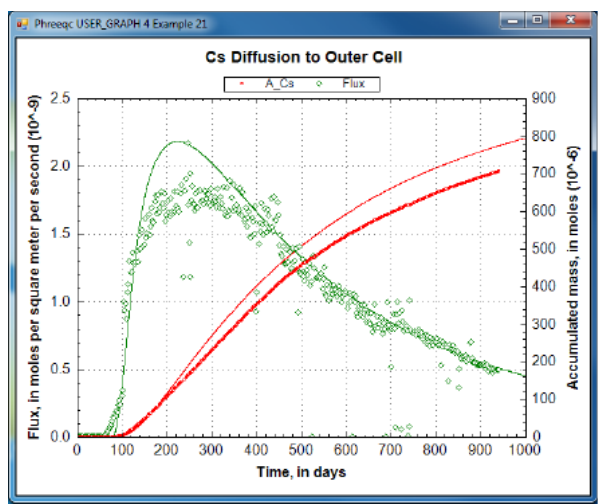
Figure 26. Mass outflow (red) and corresponding flux (green) of Cs + in the diffusion cell when interlayer diffusion is